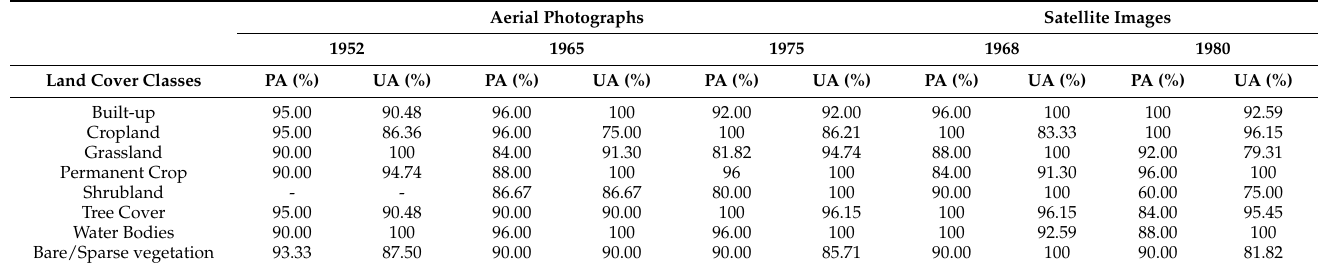
Table 8. Producer’s and user’s classification accuracies for the Stamboliyski region.